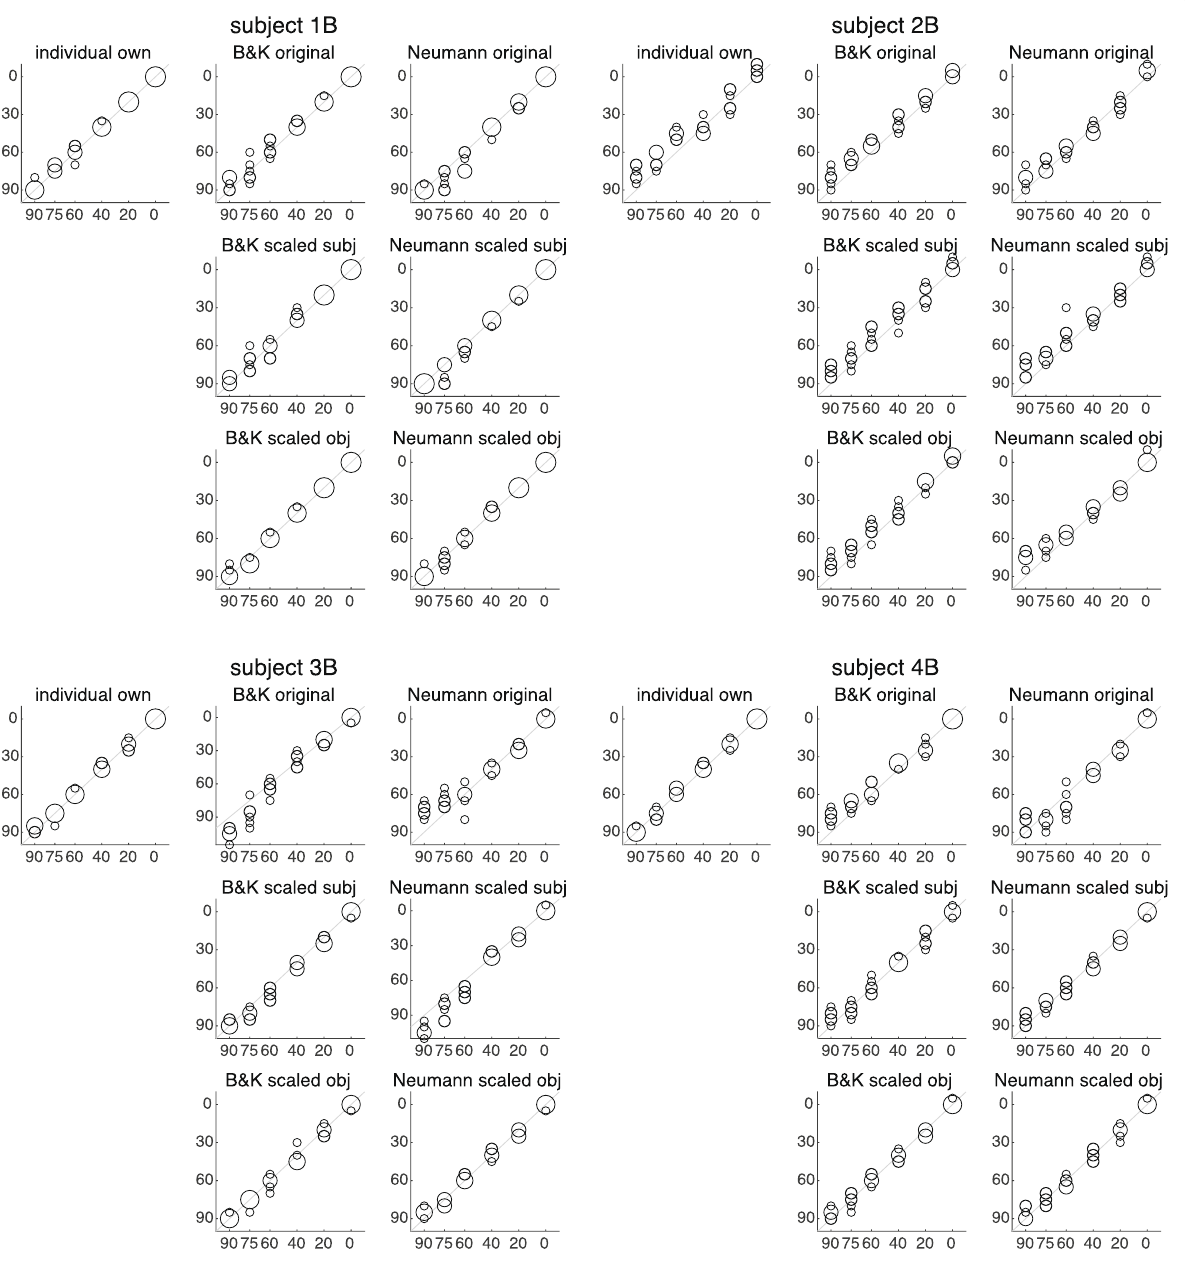
Fig. 10 Results of the validation perceptual test with individually scaled ITD. Subjects 1B to 4B. The abscissa is the simulated azimuth direction and the ordinate is the listener’s perceived direction, both in degrees. The area of each plotted circle is proportional to the number of listener’s